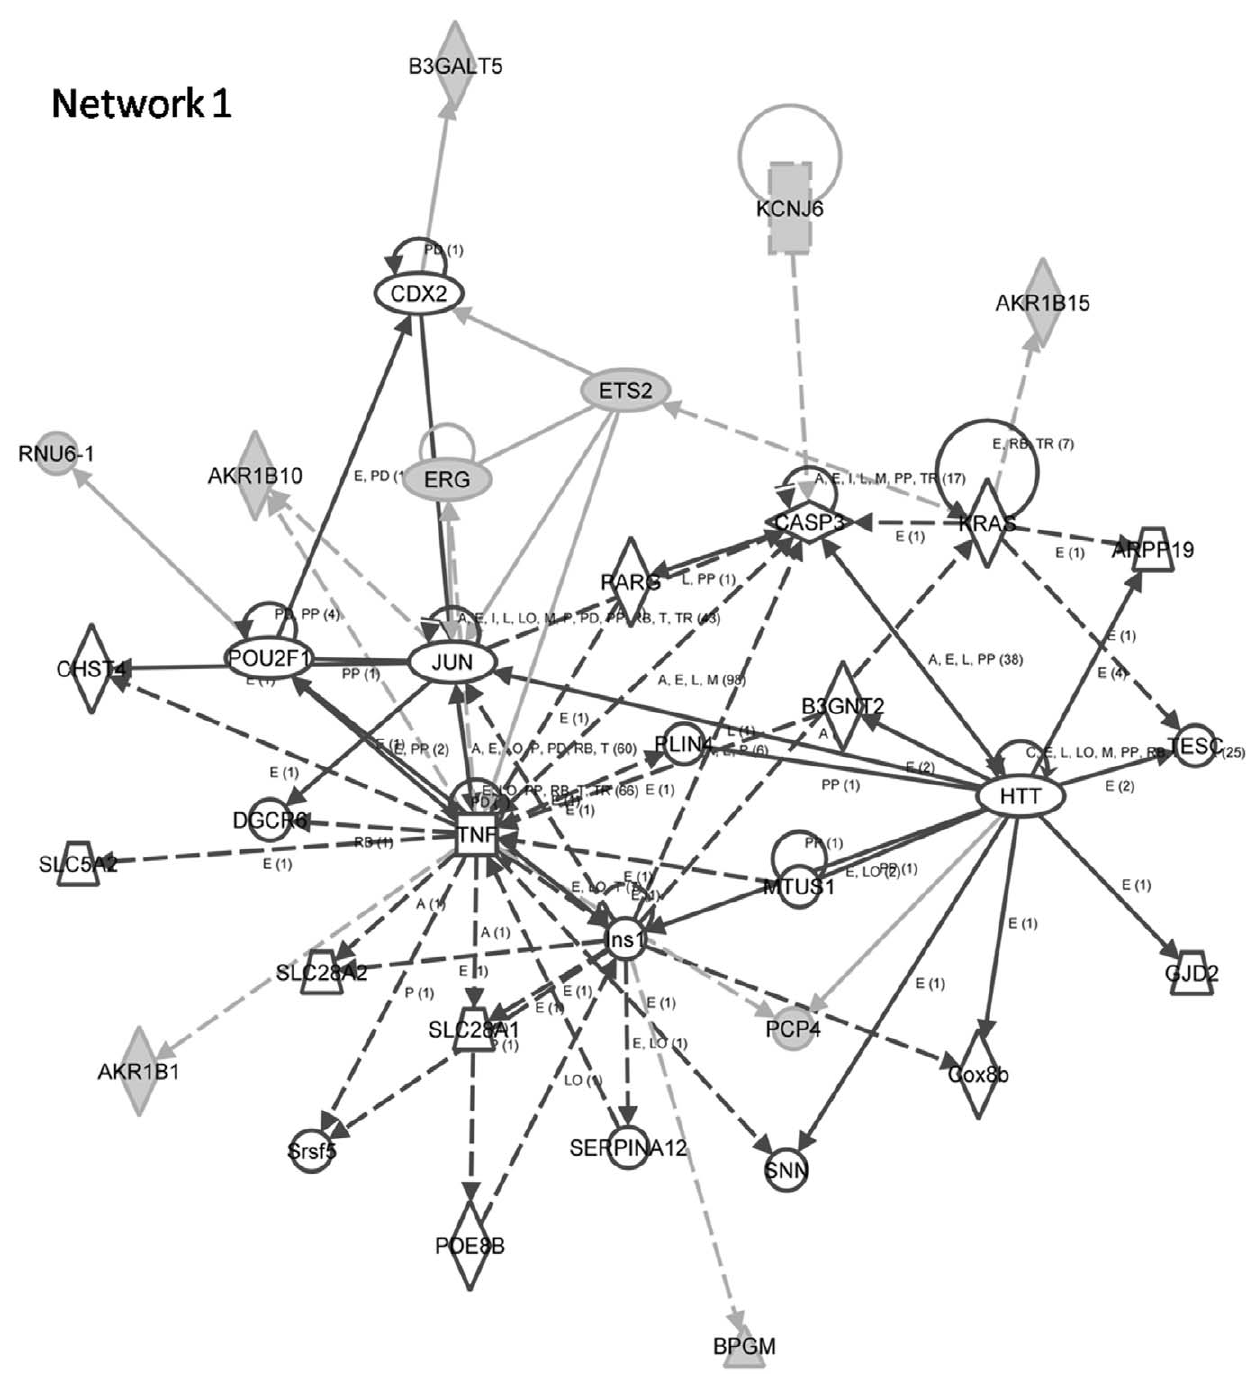
Figure 2. BQC Network 1 Drug Metabolism, Molecular Transport, Nucleic Acid Metabolism.